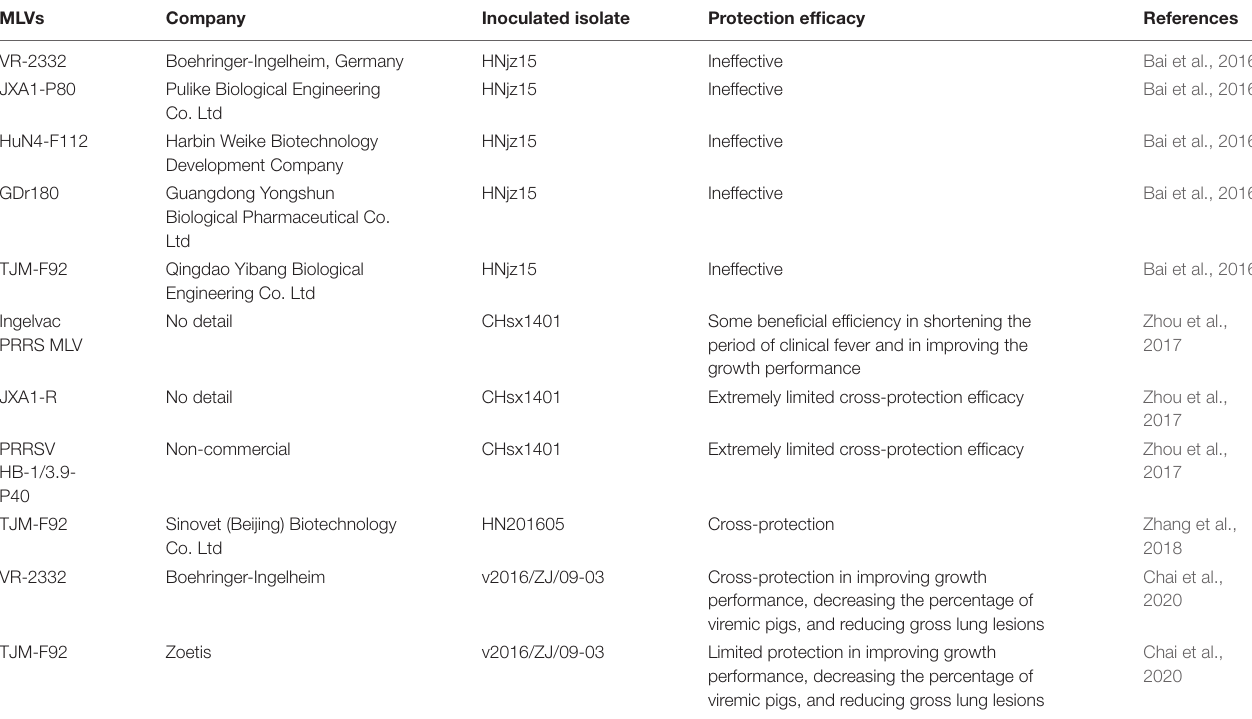
TABLE 1 | The efficacy of commercial PRRSV MLVs to NADC30-like